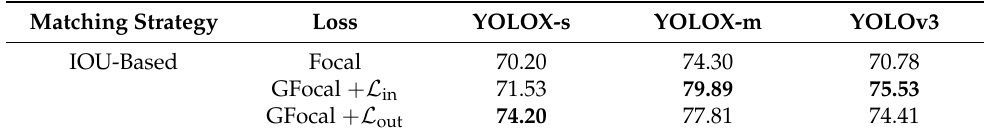
Table 2. YOLOX-s performance on VEDAI25 with different contrastive loss functions. Matching